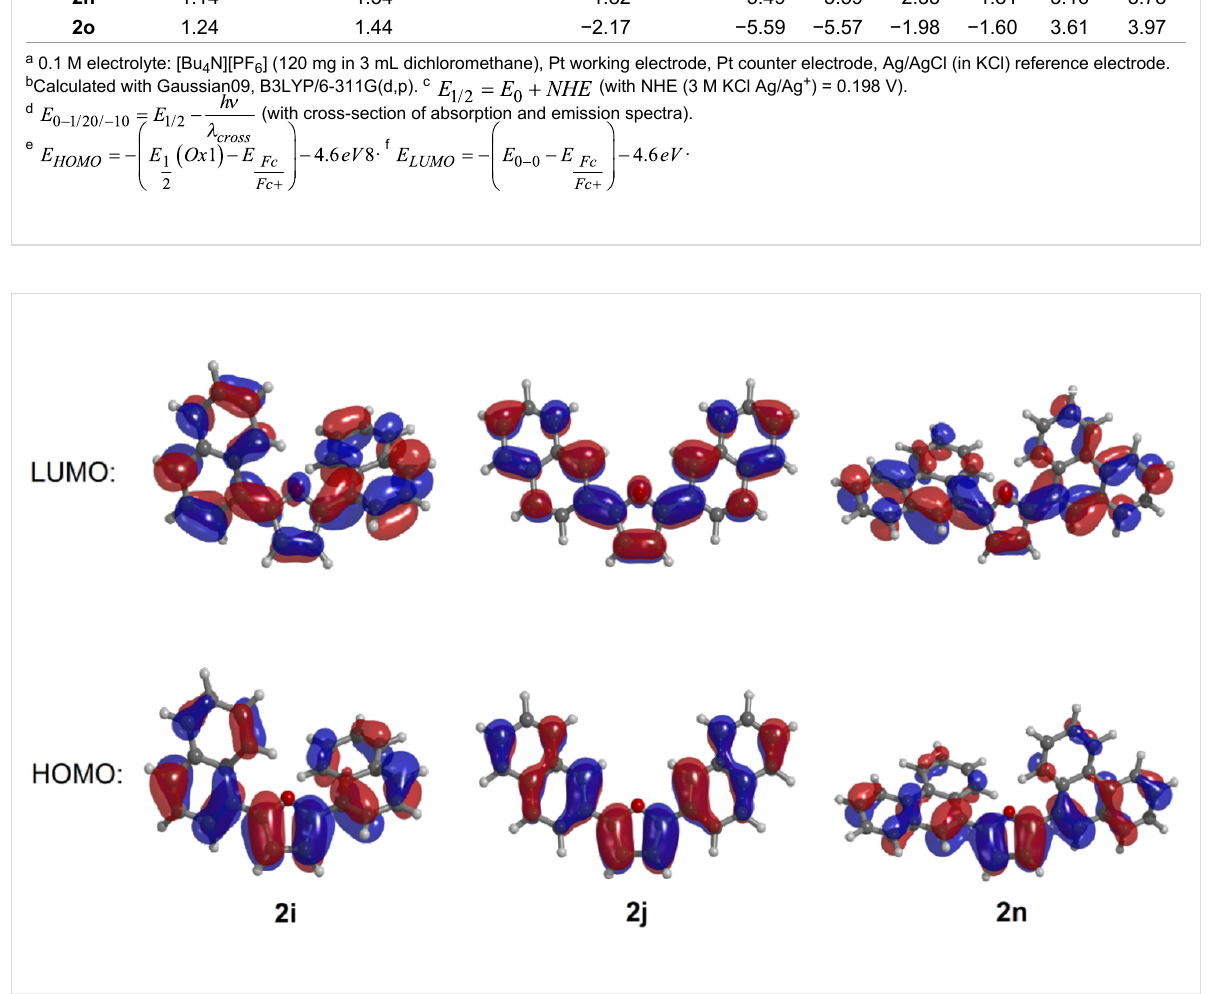
Figure 3: Kohn–Sham HOMOs (bottom) and LUMOs (top) of the compounds 2i , 2j , and 2n (calculated on the DFT level of theory (B3LYP/6-